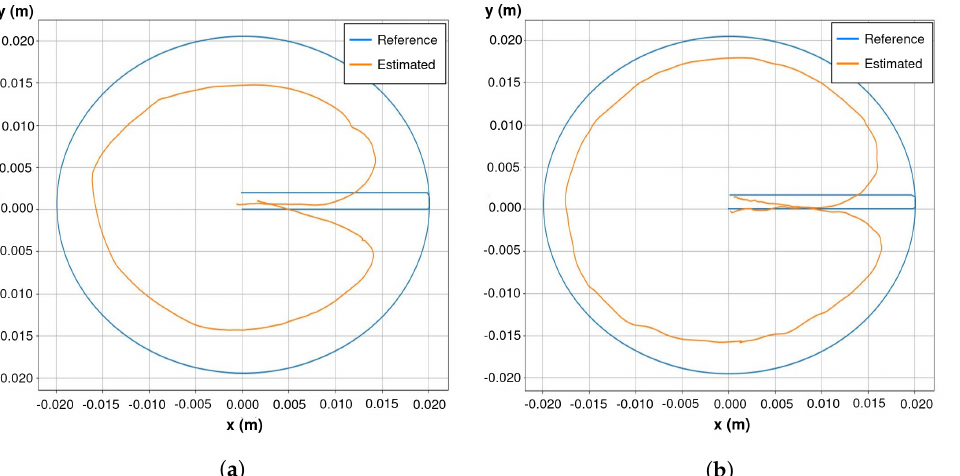
Figure 8. Body commanded and estimated position of both digital twin and physical organism. ( a ) Body trajectory of the physical organism. ( b ) Body trajectory of the digital